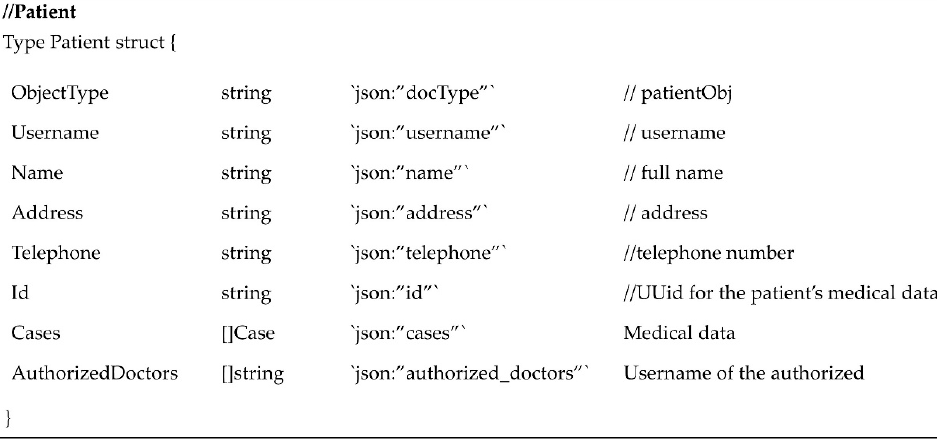
Figure 4. Data type of Patient.